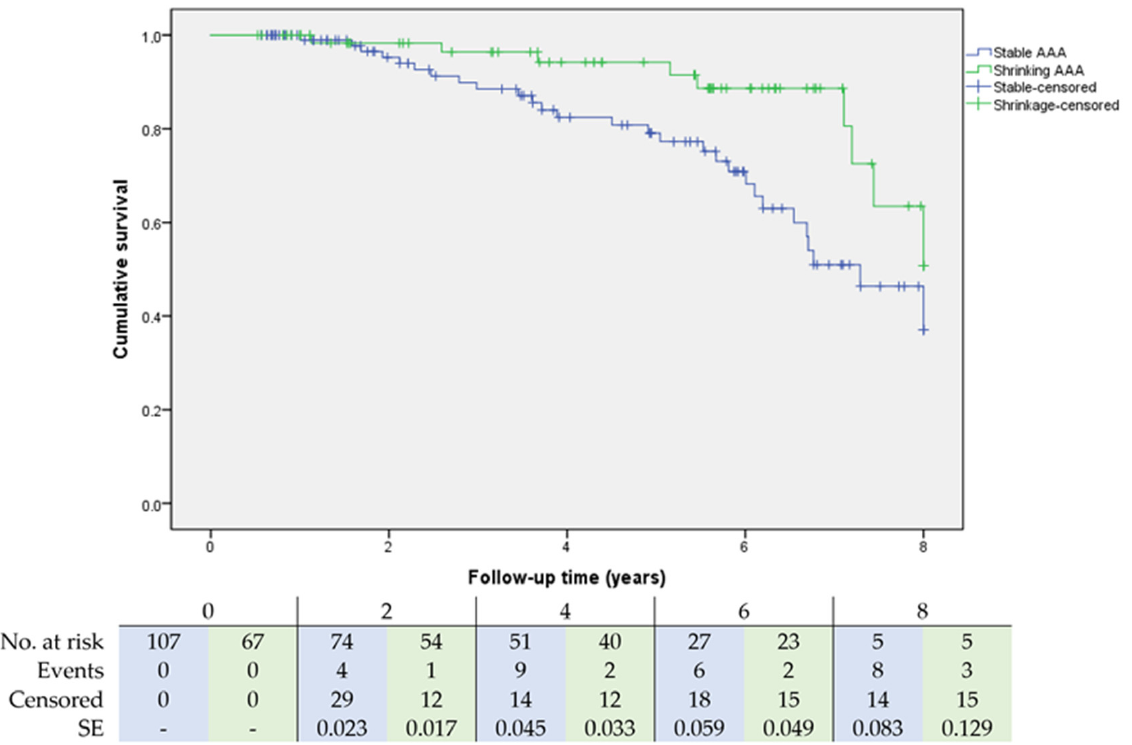
Figure 2. Kaplan-Meier survival analysis of freedom from death for stable and shrinking AAA through eight years. Number at risk represents patients at risk at that timepoint; events and censored were evaluated at end of interval. A blue color represents the stable AAA group, and a green color represents the shrinking AAA group. SE = standard error.